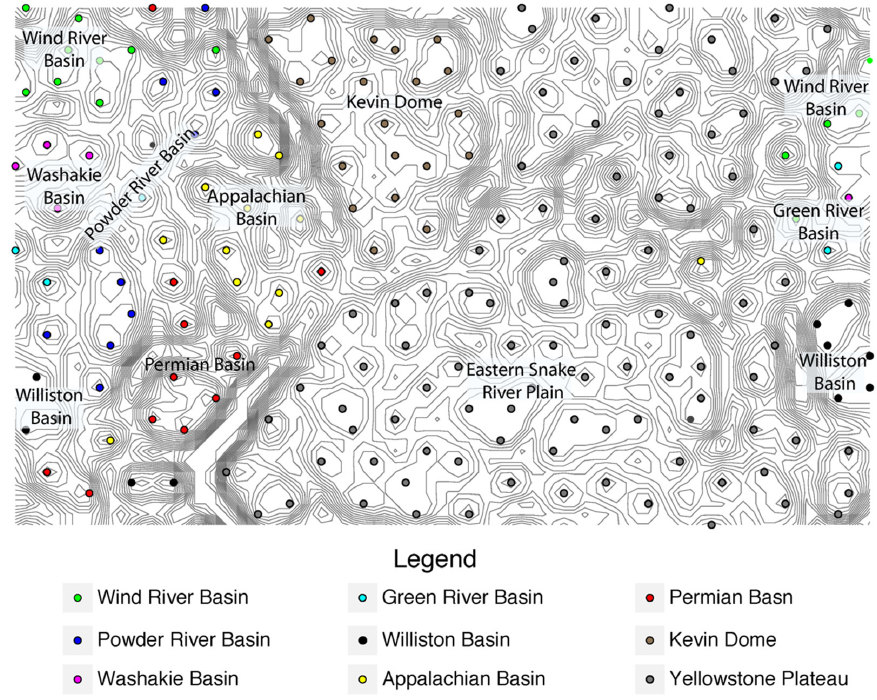
Figure 3. Foreground: Visualization of BMUs for the input data on the trained ESOM. Background: Contours of U-heights, the distance of each neuron and its neighbors. Points color-coded to indicate general sampling location.